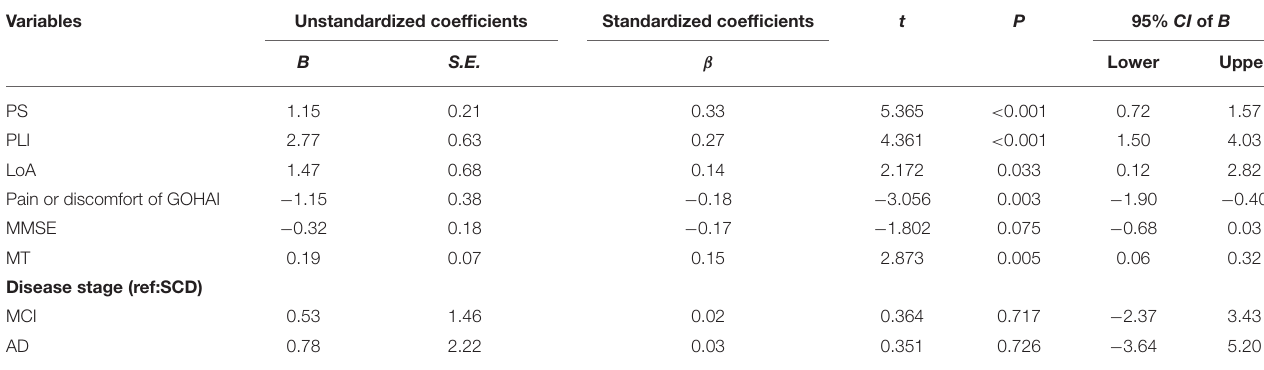
TABLE 3 | Analysis of the influencing factors of NPS among participants.